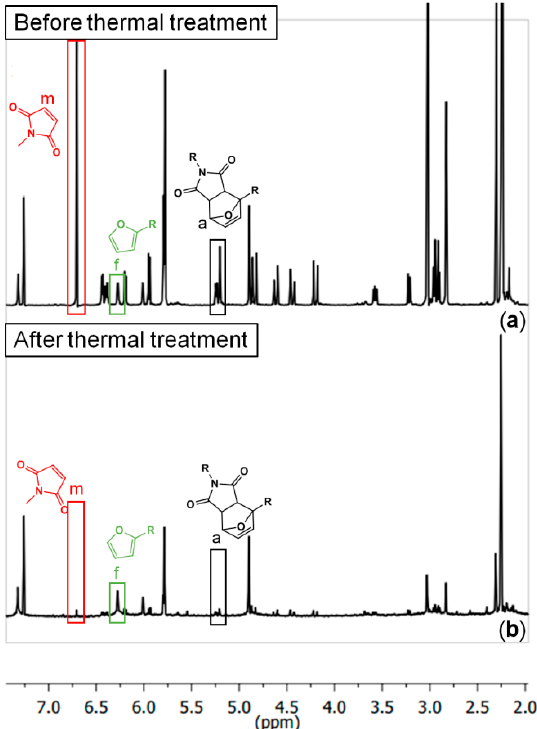
Figure 4. 1 H-NMR spectra of the DA-adduct model system ( a ) before and ( b ) after three hours at 150 °C (full interpretation in [21]).